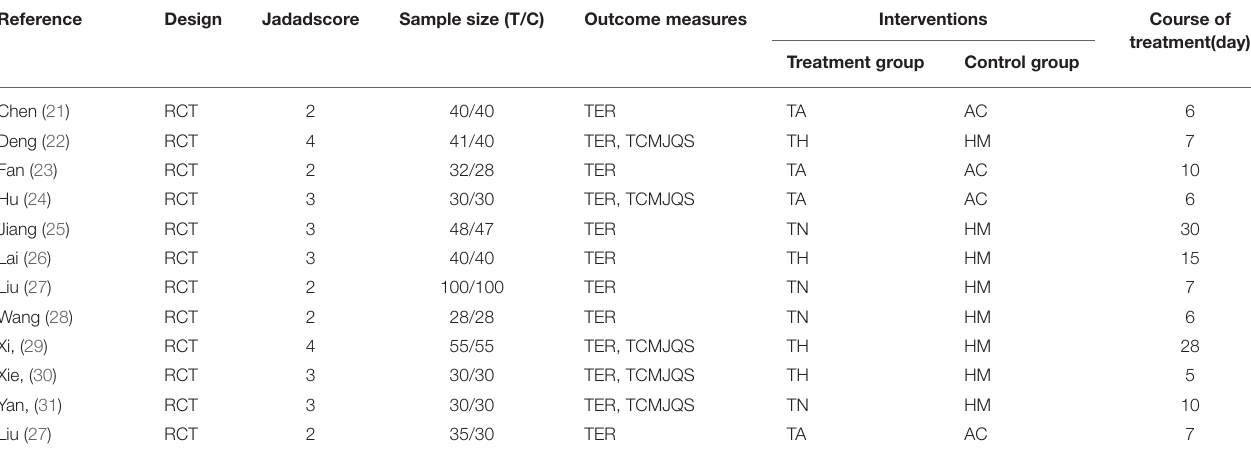
TABLE 1 | Principal characteristics of the studies included in the meta-analysis.